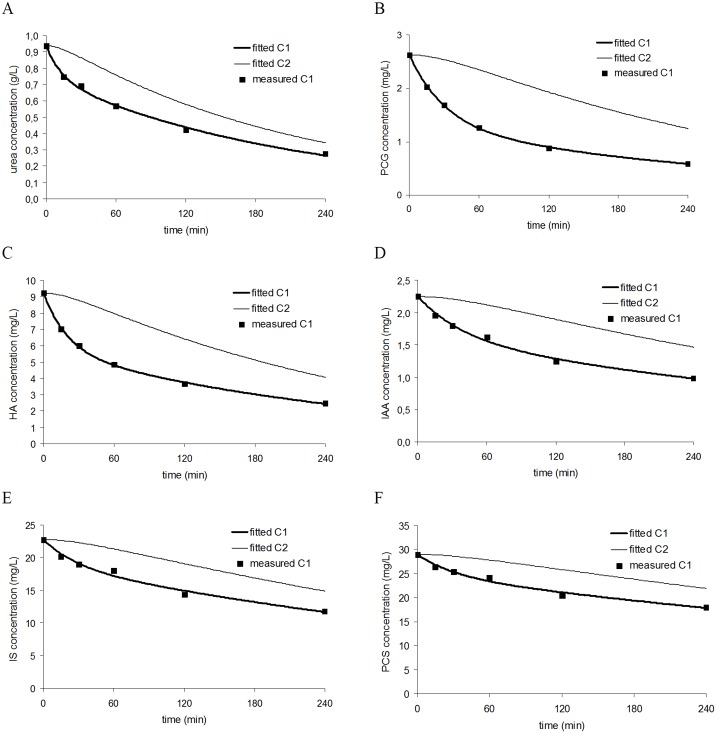
Intradialytic concentrations.Intradialytic concentrations as measured in the plasma (squares) and as simulated in the plasmatic compartment (C1—bold line) and extraplasmatic compartment (C2—thin line) of a representative patient for urea (panel A), p-cresylglucuronide (PCG) (panel B), hippuric acid (HA) (panel C), indole acetic acid (IAA) (panel D), indoxyl sulfate (IS) (panel E), and p-cresylsulfate (PCS) (panel F). All solutes show a substantial slower decline of concentration in the extraplasmatic compartment.